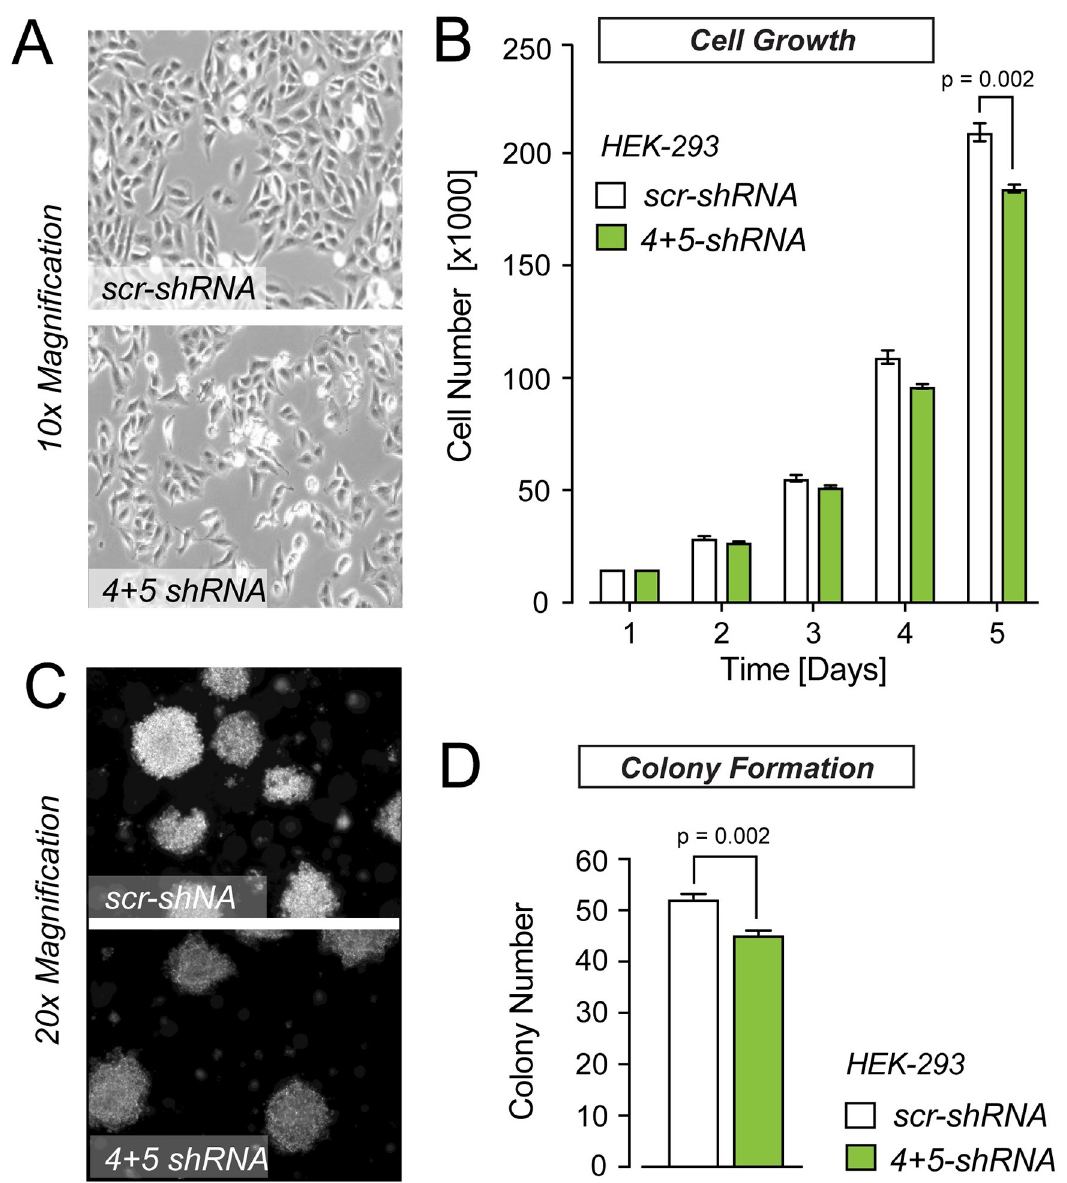
Fig 3. PFKFB3-4+5 knockdown leads to decreased cell growth and colony formation. (A) Representative brightfield image of scr- shRNA (upper panel) and 4+5 shRNA treated (lower panel) HEK-293 cells cultured in 12-well plates. Image was taken after five days of cell seeding. (B) Quantification of cell growth of HEK-293 cells with stably reduced levels of PFKFB3-4+5 compared to cells expressing scr-shRNA. 5000 cells/12-well for each condition. The colony numbers are the mean ± SEM. The cell growth experiment was done as duplicate determinations with three independent experiments (N = 3, n = 2). The cell number was quantified by cell counting in 12-well plates every 24 hours until approximately 80% confluency was reached. All groups were compared using the Mann Whitney test. (C) Representative images of soft agar colonies formed by HEK-293 cells (scr-shRNA) and HEK-293 cells with stably reduced PFKFB3-4+5 levels (4/5 shRNA). The cells (5000 cells) were cultured for 14 d in 6-well plates on soft agar. (D) Quantification of HEK-293 cell colonies from (C) after 14 d in culture. The colony formation was quantified in three independent experiments as duplicates (N = 3, n = 2). The numbers are the mean ± SEM. The groups were compared using Mann Whitney test.